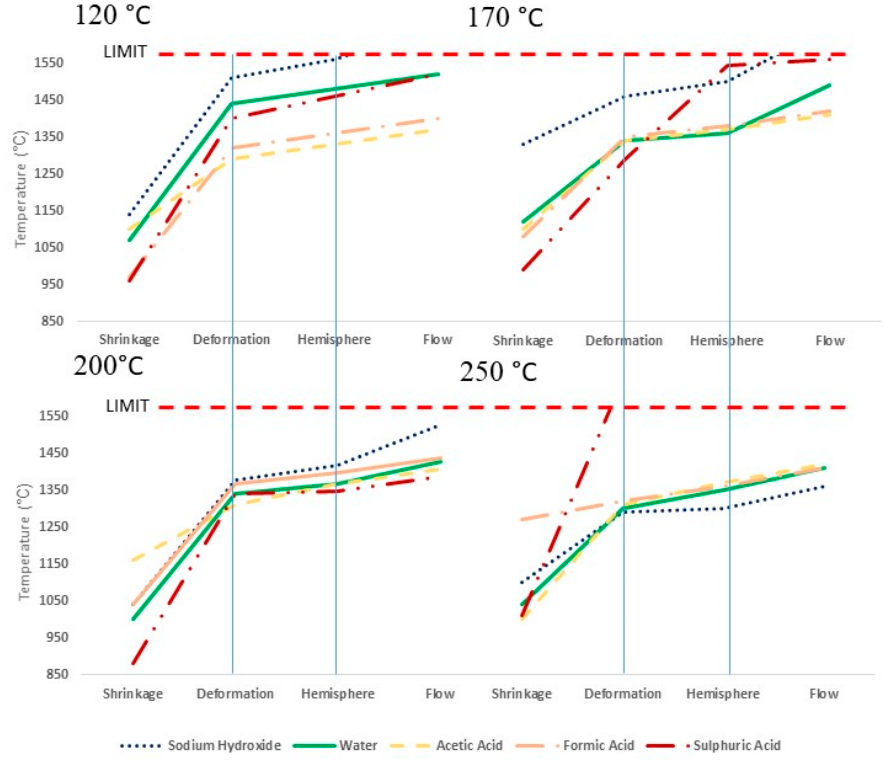
Figure 3. Ash transition temperatures from the ash fusion test for the different treatments at differing hydrothermal treatment temperatures .